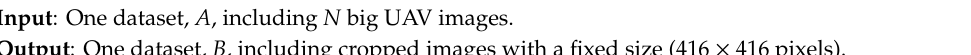
Figure 2. Preliminary processing for poppy selection: ( a ) original images; ( b ) verified images; ( c ) labeled images; ( d ) labeled information.